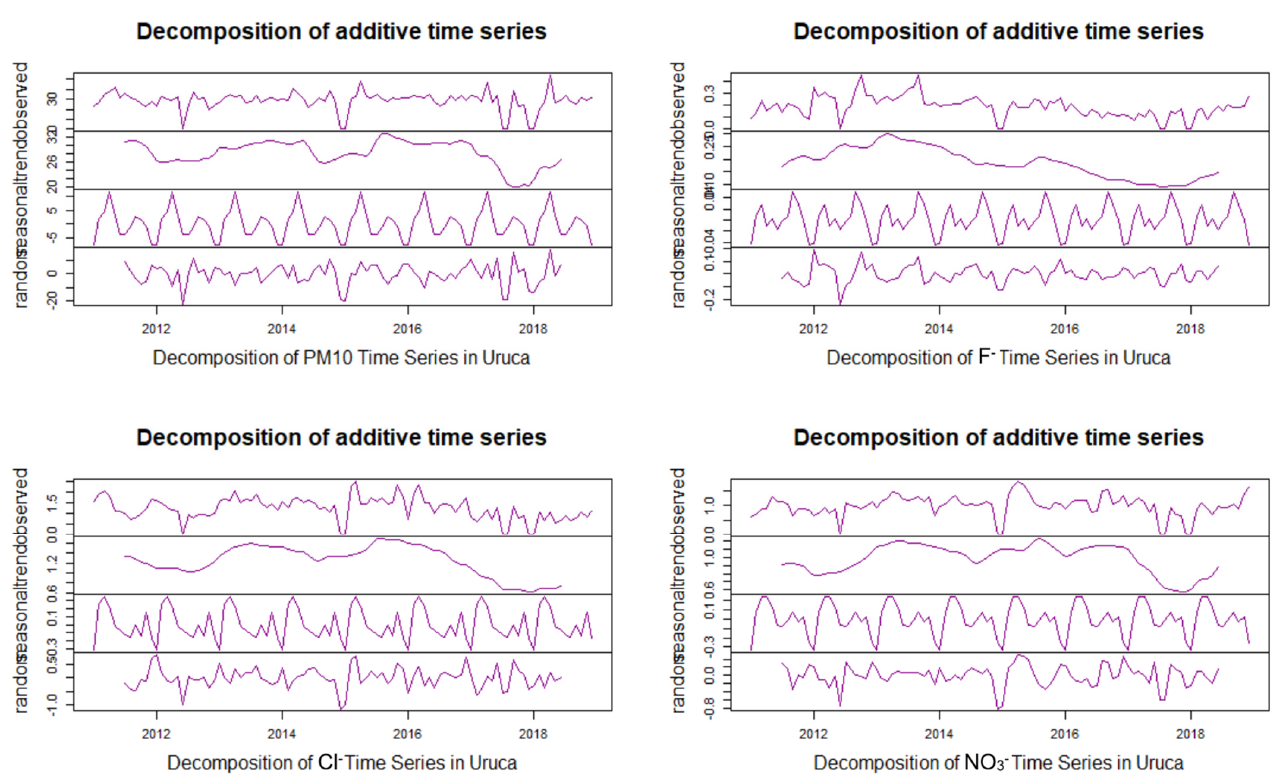
Figure 6. Decomposition of additive time series for the UR sampling site, 2011–2018 .